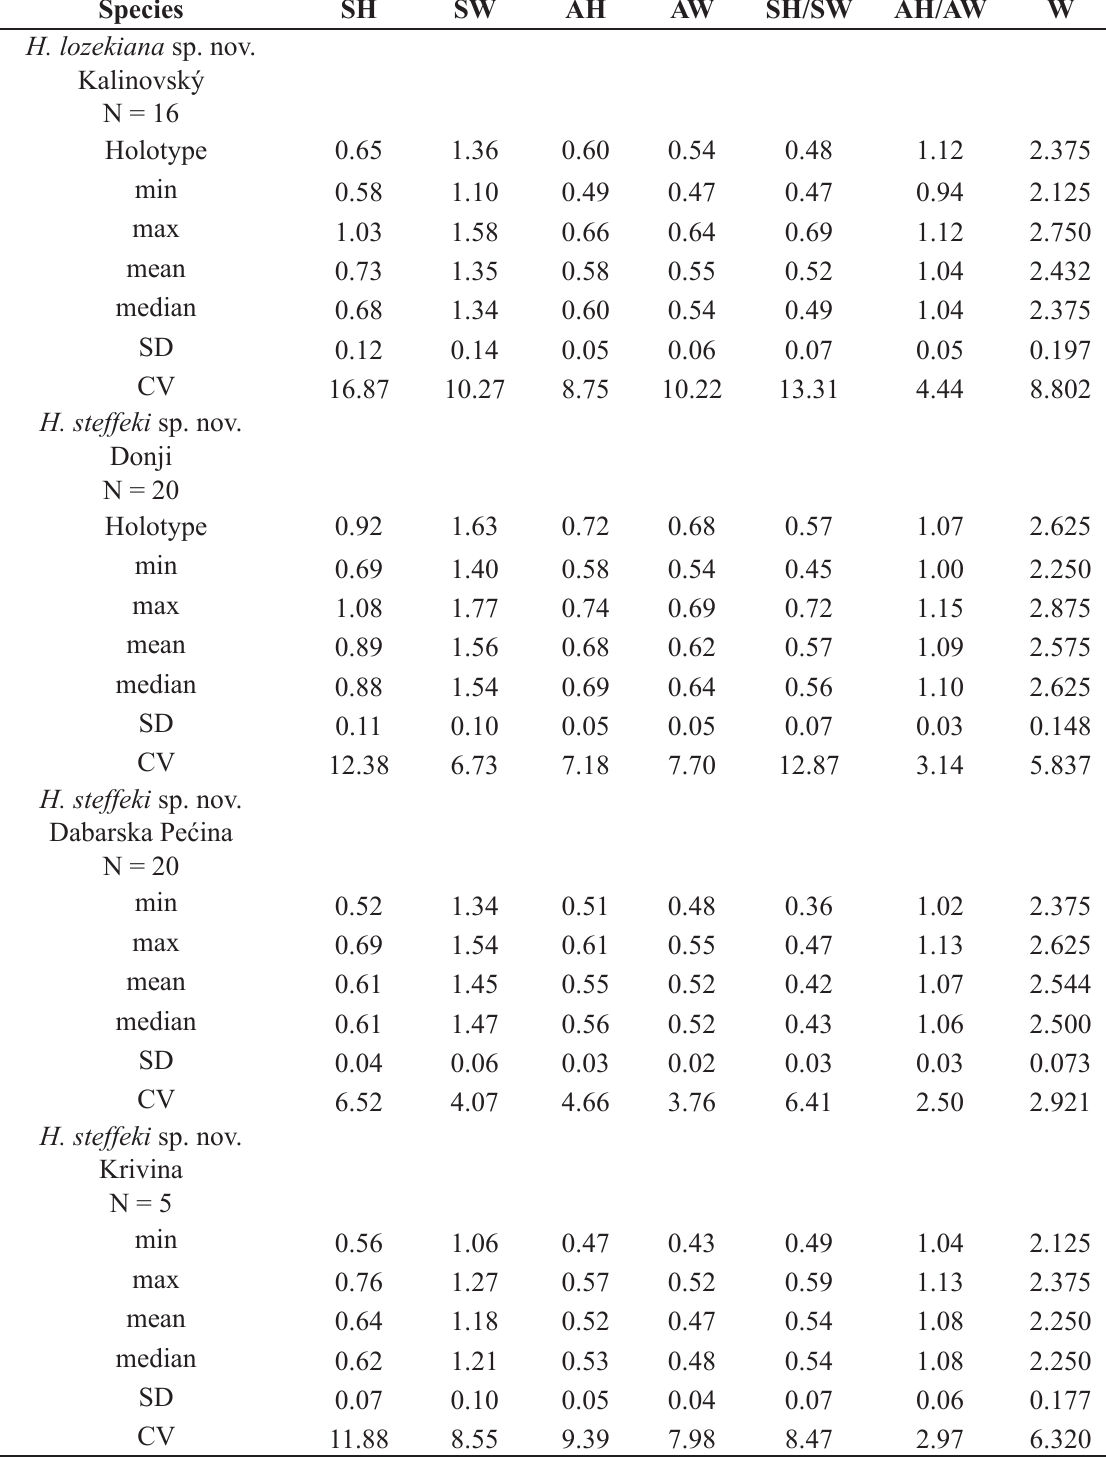
Table 4. Morphometrics of the new species. Abbreviations: AH = aperture height; AW = aperture width; CV = coefficient of variation corrected for unequal sample sizes; max = maximum; min = minimum; SD = standard deviation; SH = shell height; SW = shell width; W = number of whorls (to the nearest eighth). Measurements in